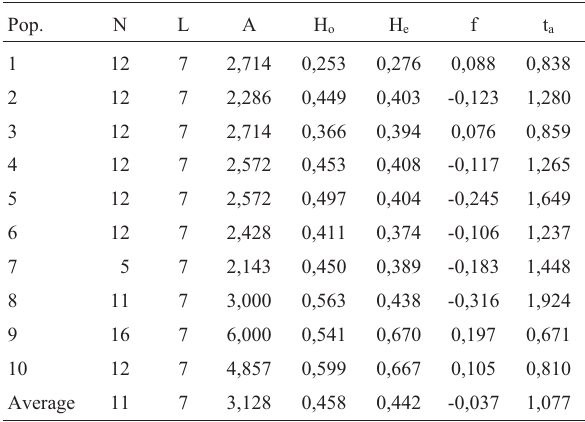
Table 4 - Estimates of genetic parameters in ten Eugenia dysenterica populations N: number of individuals sampled, L: number of microsatellite loci; A: mean number of alleles; H o : Observed heterozygosity; H e expected heterozygosity; f: fixation index; t a : apparent crossing rate.